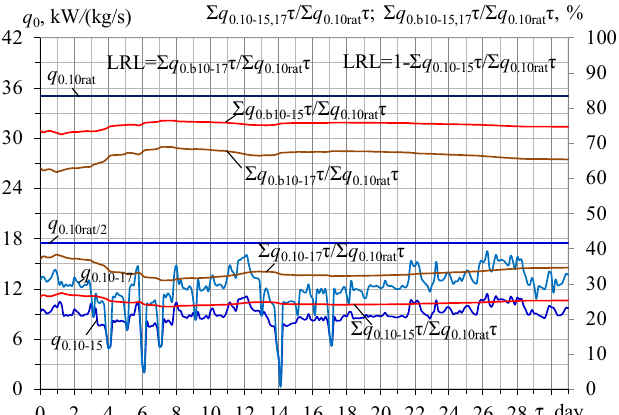
Figure 10. Actual values of refrigeration capacities q 0.10–15,17 for subcooling the air from 15 and 17 ◦ C to 10 ◦ C; corresponding relative summarized refrigeration energy consumed for subcooling the air from 15 and 17 ◦ C to 10 ◦ C ∑ ( q 0.10–15,17 τ )/ ∑ ( q 0.10rat τ ); relative summarized residual booster refriger- ation energy available for precooling the ambient air to 15 and 17 ◦ C: ∑ ( q 0.b10–15,17 τ )/ ∑ ( q 0.10rat τ ): q 0.10–15,17 = q 0.10 − q 0.15,17 ; q 0.b10–15,17 = q 0.10rat − q 0.10–15,17 .